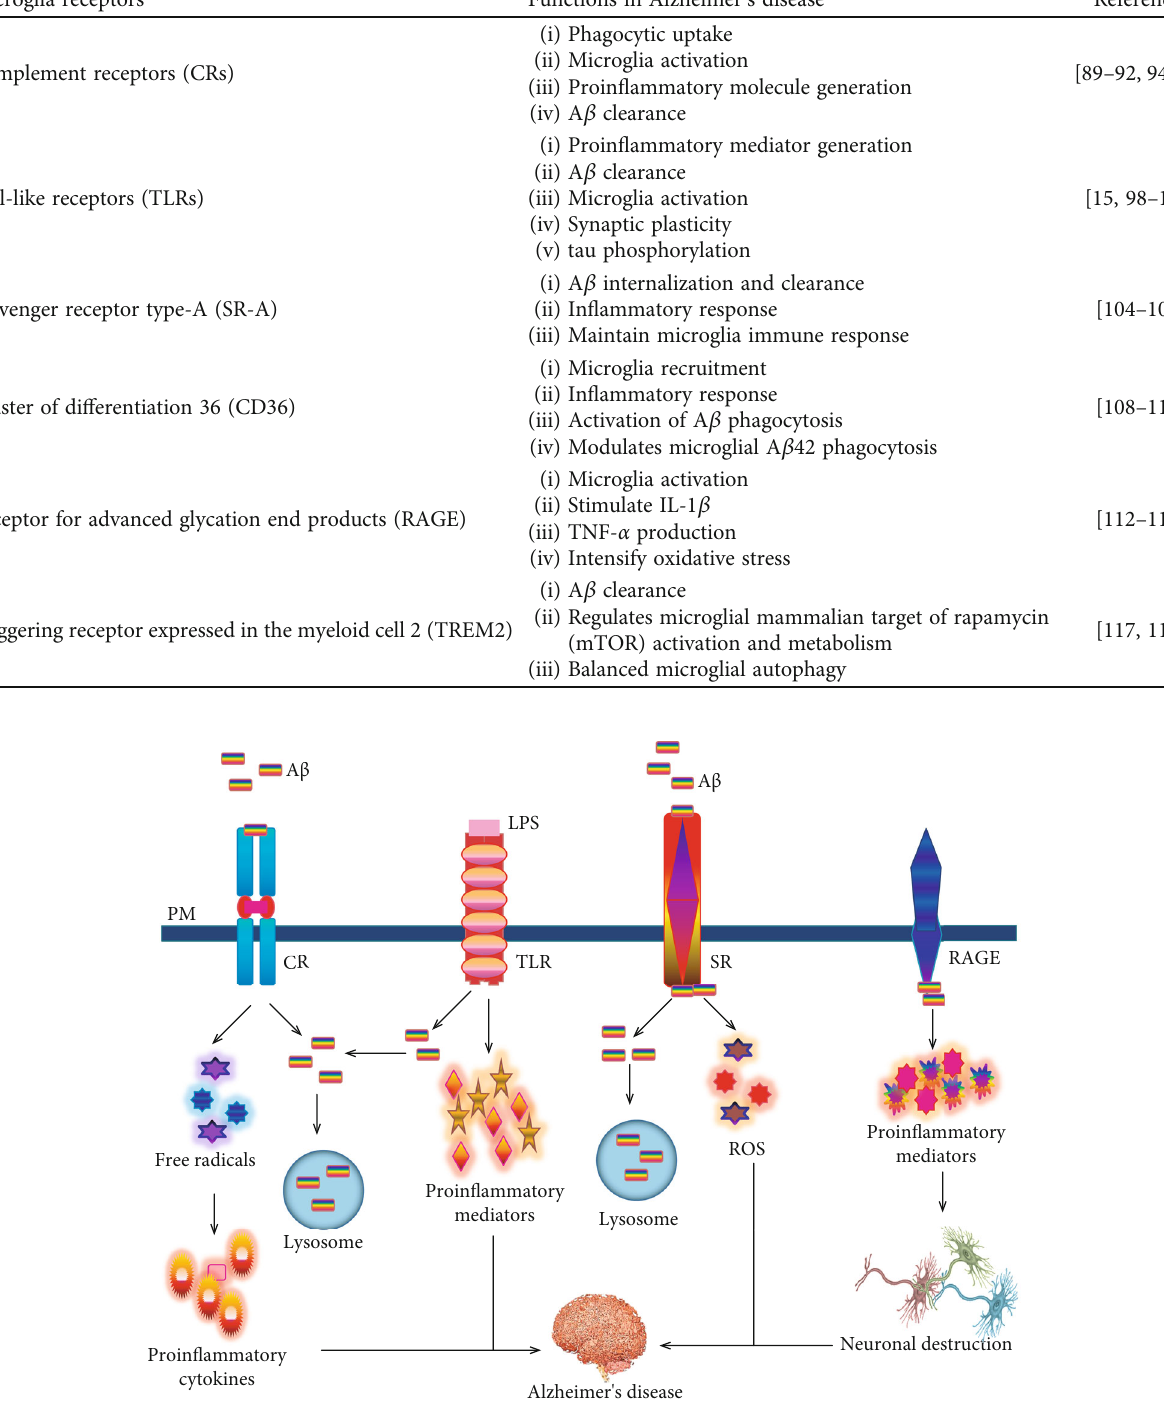
Figure 2: The linkage of microglia receptors in the pathogenesis of Alzheimer ’ s disease. CR3 is responsible for the A β -induced microglial activation and involved in A β -mediated microglia free radical generation as well as uptake and clearance of A β . TLR2 is implicated in the generation of the in fl ammatory response. On the other hand, TLR4 (i.e., stimulated with LPS) is associated with the clearance of A β